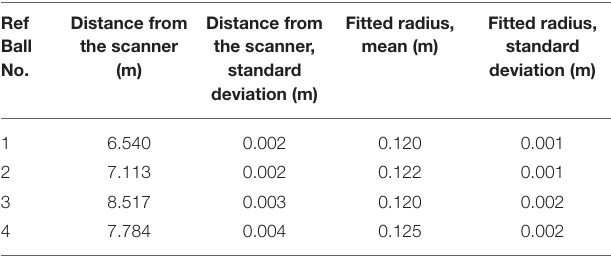
TABLE 2 | The ranging stability of the FGI HSL point cloud during the